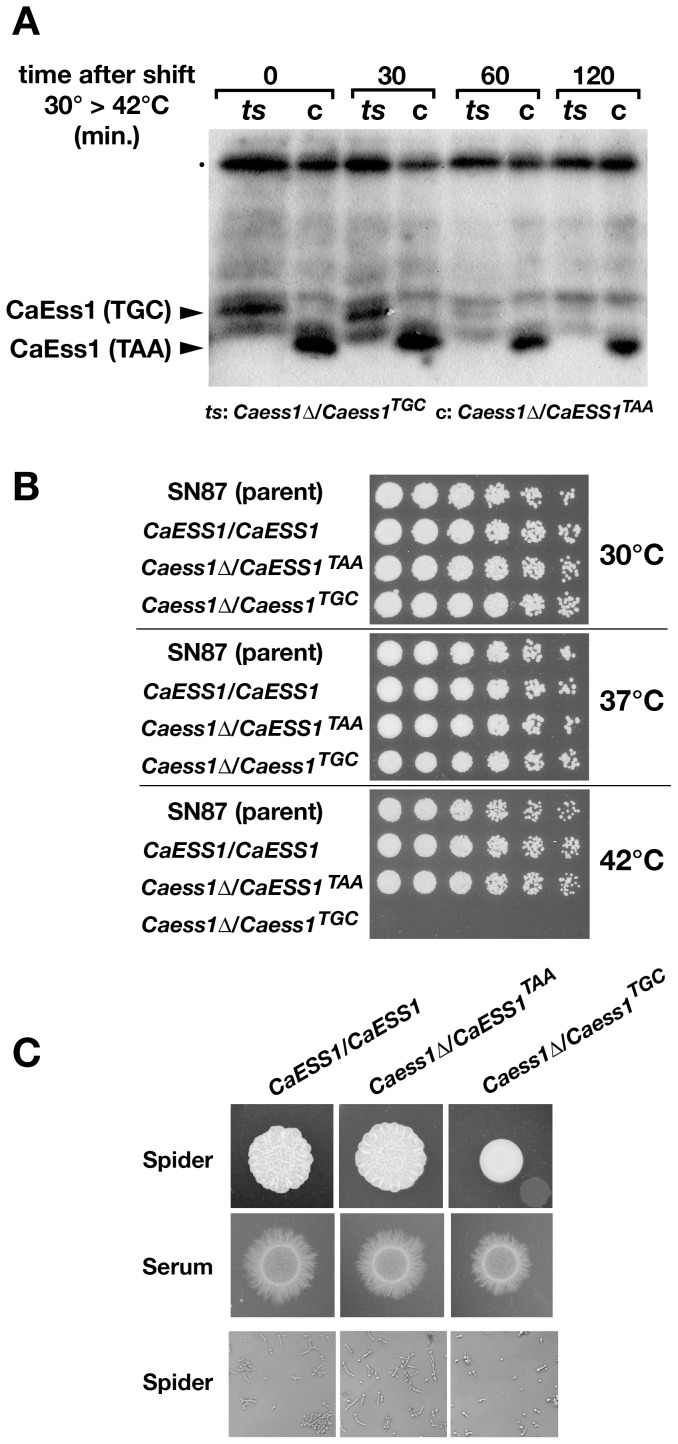

CaESS1 is essential for the growth of C. albicans.(A) Western analysis of C. albicans whole cell extracts to detect expression of wild-type CaEss1 (TAA) and a larger protein product encoded by the Caess1TGC “readthrough” allele (TGC). The level of read-through protein is reduced significantly at 60 min and is nearly absent after 2 hrs at non-permissive temperature (42°C). A total of 7.5 µg of protein was used per lane. The blot was probed using anti-CaEss1 polyclonal antibody at a 1∶500 dilution. (B) Serial dilution (1∶3) of cells of the indicated genotype grown on solid medium (YPD) at different temperatures. The readthrough strain, Caess1Δ/Caess1TGC shows a clear temperature-sensitive phenotype at 42°C, but no growth defect at 37°C. (C) Filamentation on the indicated solid medium (4 days) (upper two rows), and germ tube formation in liquid Spider medium (2 hrs) (lower row). Upper two rows are reproduced from
Figure 2
 for comparison. In (B) and (C), CaDS-B5 (CaESS1/CaESS1) is used as the wild-type, and is an isogenic control for both the TAA and TGC strains.